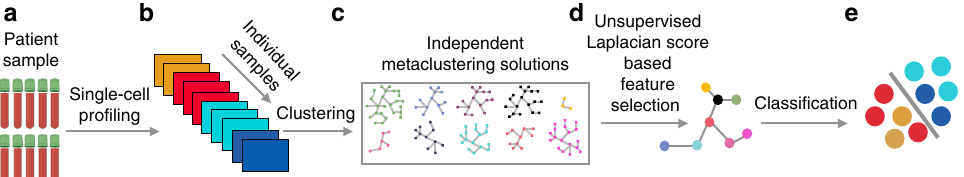
Fig. 1 An overview of the VoPo pipeline for robust clinical outcome prediction. VoPo is an end-to-end bioinformatics pipeline for prediction and visualization of high-throughput single-cell data. a Patient samples are collected and the immune system is pro fi led at a single-cell level (image created with BioRender.com). b Cells from individual samples are fi rst assigned to within-sample clusters. c A collection of cell populations (metaclusters) common to all samples is de fi ned through repeated metaclustering. Each uniquely colored graph is a schematic representation of a unique metaclustering solution, with each node representing a metacluster. d Unsupervised Laplacian Score-based feature selection is applied independently to each metaclustering solution to reduce feature redundancy. This results in a collection of features acquired collectively across the independent metaclustering solutions. The color of a node (e.g., retained metacluster) schematically represents the metaclustering solution where it was produced (from c ). e The features retained across independent metaclustering solutions are integrated and used to classify patients according to clinical